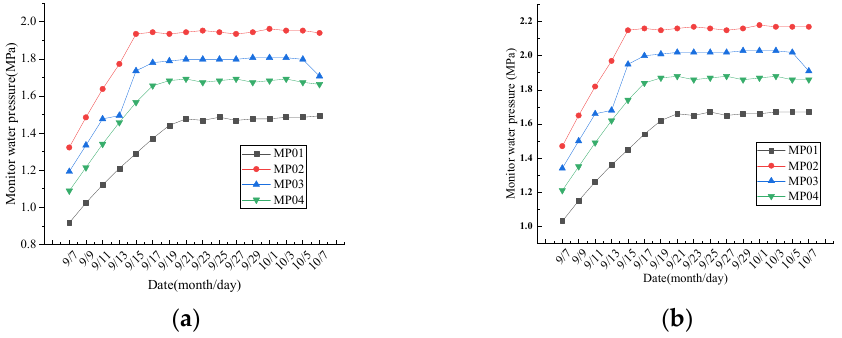
Figure 8. Monitoring results of water pressure outside the lining at S1ZK0 + 660 m and S1ZK0 + 735 m of the No. 1 vertical auxiliary shaft [36]. ( a ) S1ZK0 + 660 m; ( b ) S1ZK0 + 660 m.